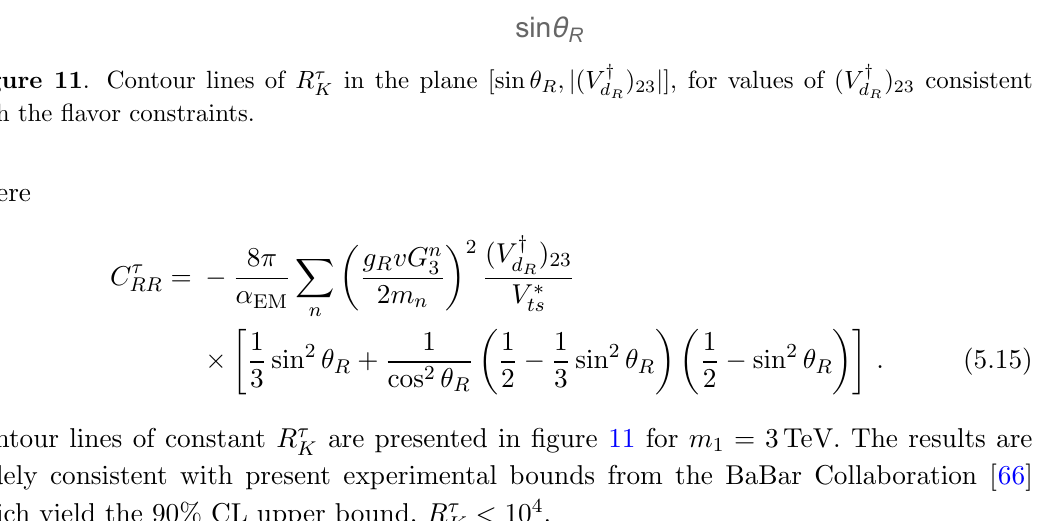
in the plane [sin (cid:18) R ; j ( V y K